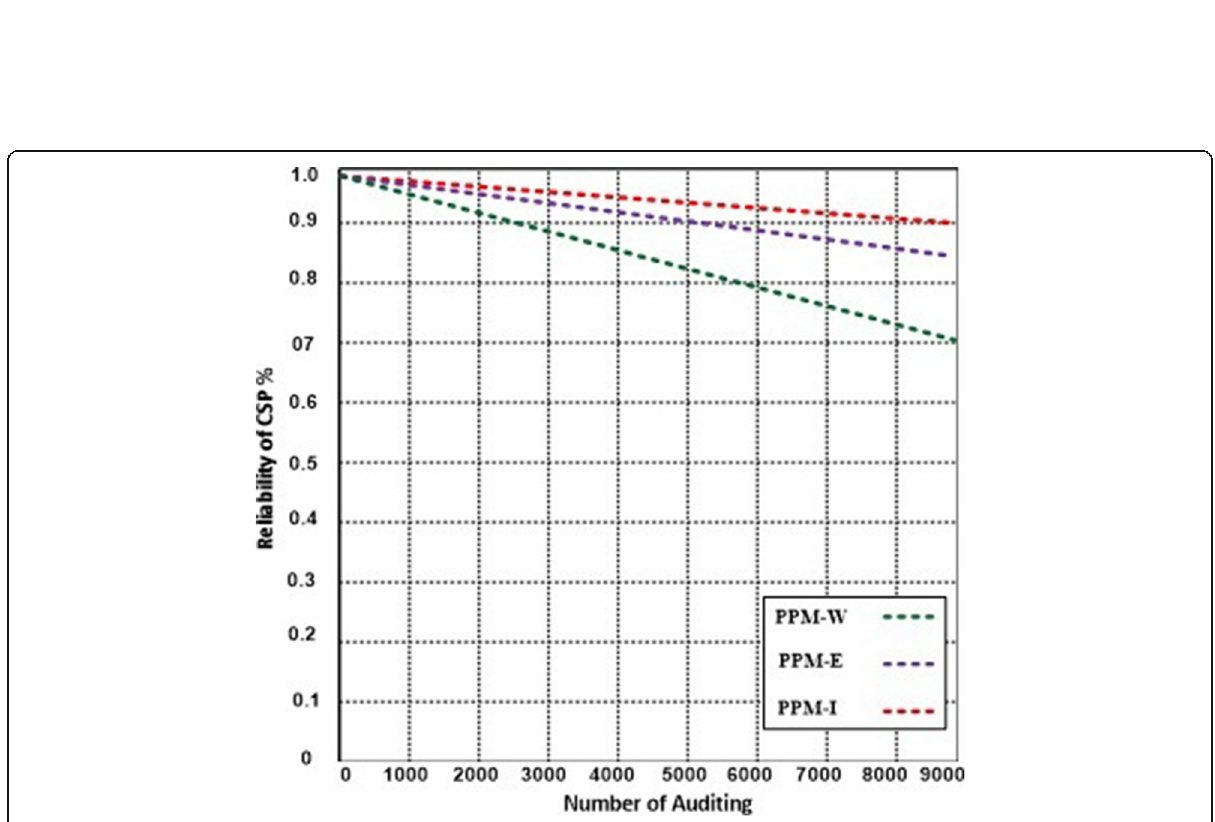
Fig. 12 Reliability of CSP on Number of